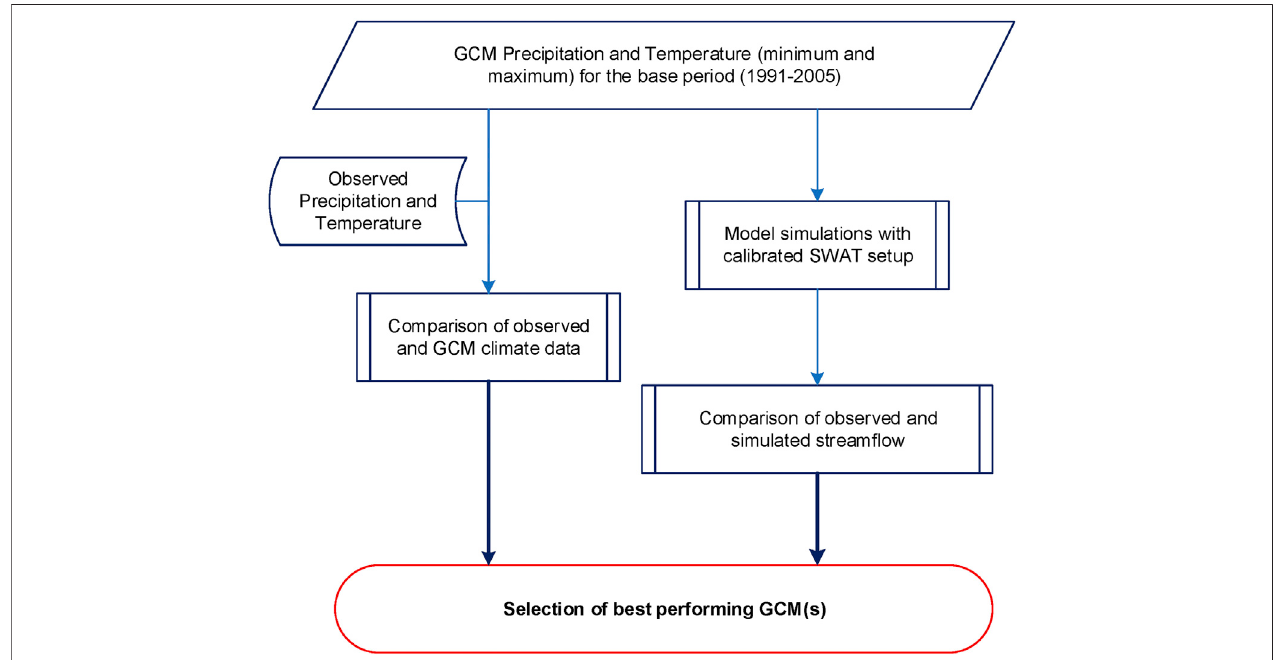
FIGURE 3 | The work fl ow adopted in this study for GCM selection for stream fl ow simulation in the Irrawaddy River Basin.